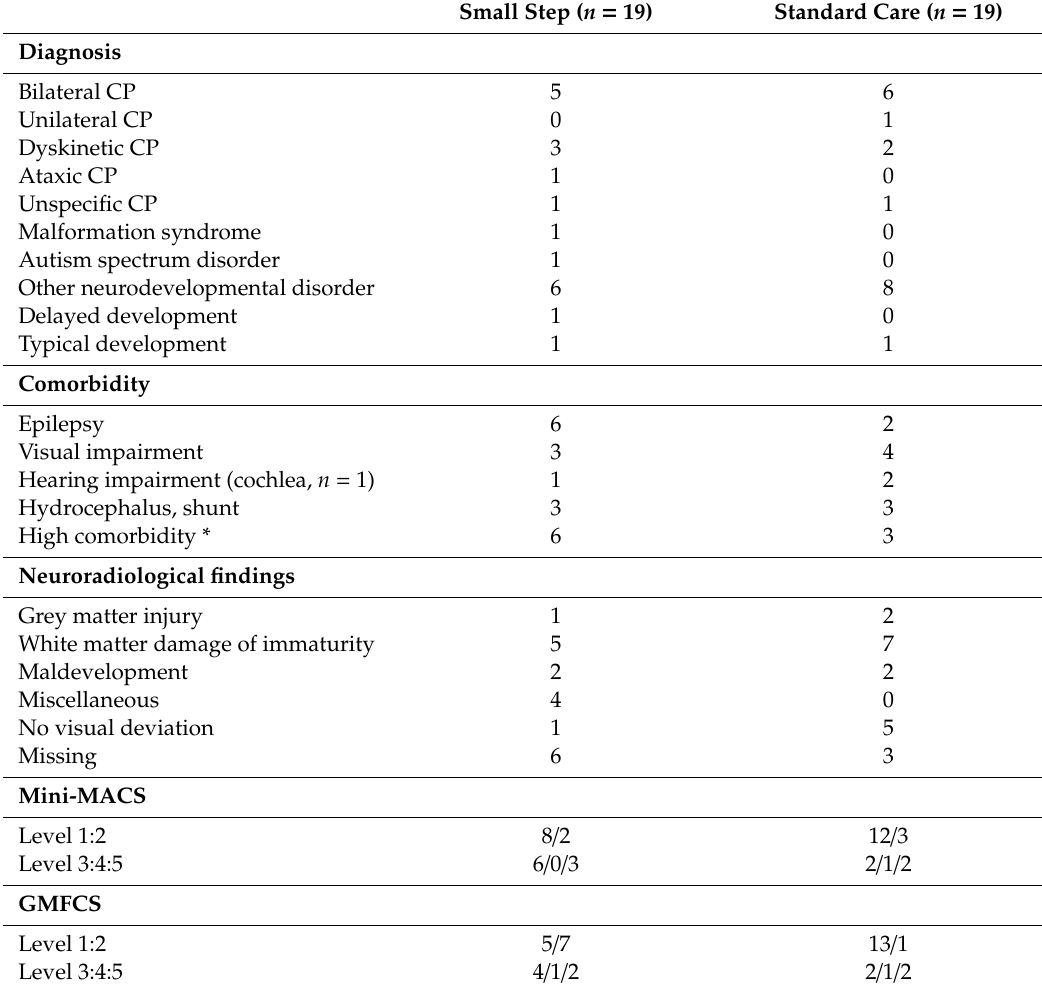
Table 4. Diagnostic information on participants, collected at 2 years of age. Small Step ( n =